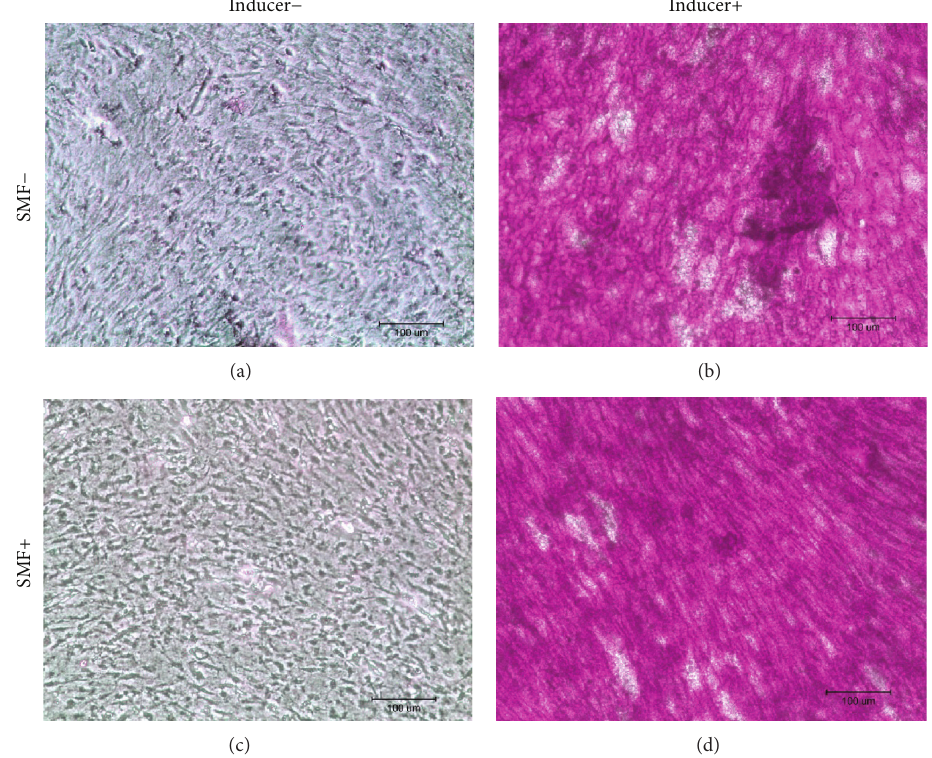
Figure 3: Results of Alizarin Red staining showed the calcified deposition in red. There were no significant differences between SMF-exposed and sham-exposed cells after osteogenesis induction. Neither of noninduction controls had calcified deposition